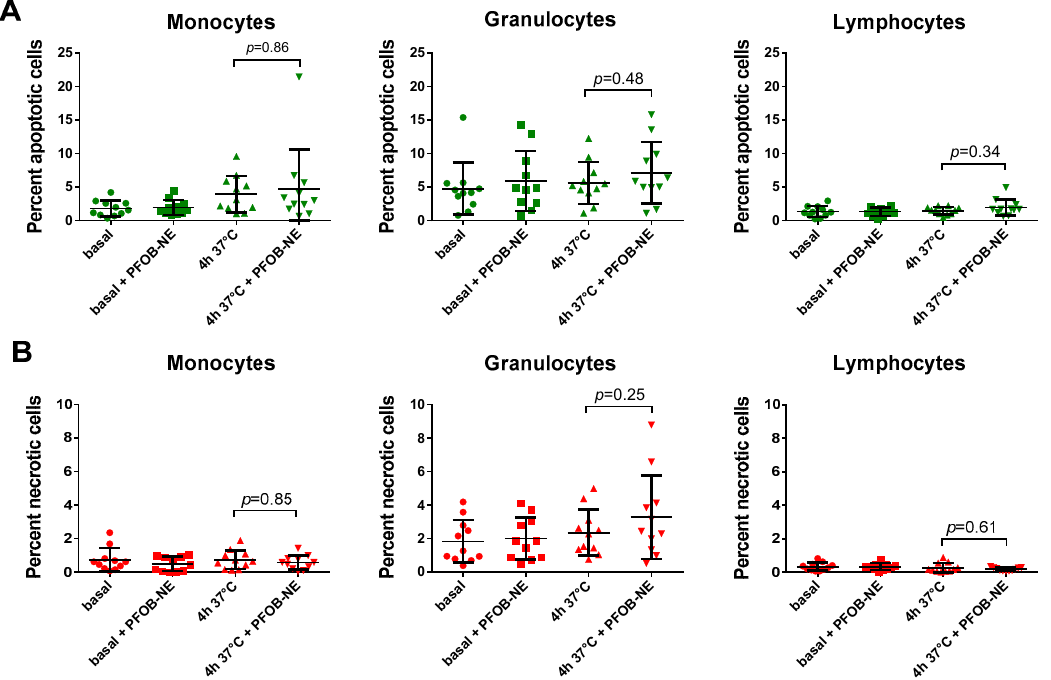
Figure 4. Leukocytes remain viable after PFOB-NE ingestion. The graphs show the percentage of ( A ) apoptotic and ( B ) necrotic monocytes, granulocytes and lymphocytes after 4 h of PFOB-NE exposure. Cell viability was discriminated via flow cytometry. No significant differences in the percentage of apoptotic or necrotic cells were observed after 4 h of PFOB-NE exposure ( n = 11